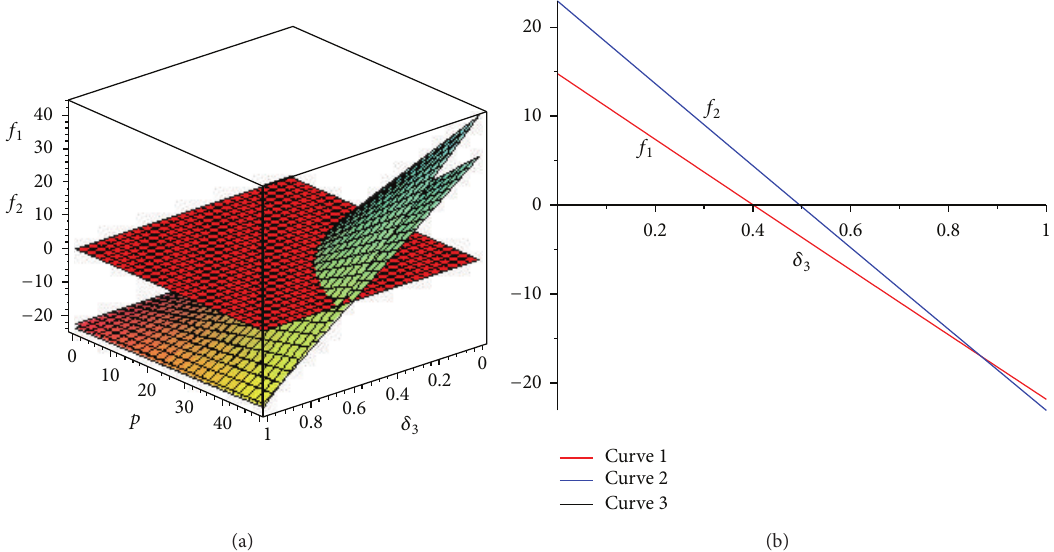
Figure 1: (a) The relationship diagram of the function 𝑓 1 (𝑝,𝛿 3 ) and the function 𝑓 2 (𝑝,𝛿 3 ) with respect to the parameters 𝑝 and 𝛿 3 ; (b) the relationship diagram of the function 𝑓 1 (𝑝,𝛿 3 ) and the function 𝑓 2 (𝑝,𝛿 3 ) with respect to the parameter 𝛿 3 with 𝑝 = 35 .